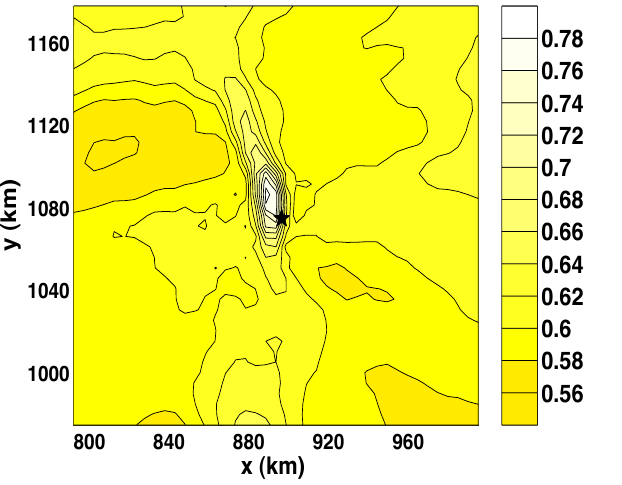
Fig. 8. Anisotropic steady-state simulation: Eigenvalue a 3 of the second-order orientation tensor a ( 2 ) at 95% depth (contour spacing 0.02). The black star indicates the location of the Dome Fuji drill site, north is towards the top right (see Fig. 1).